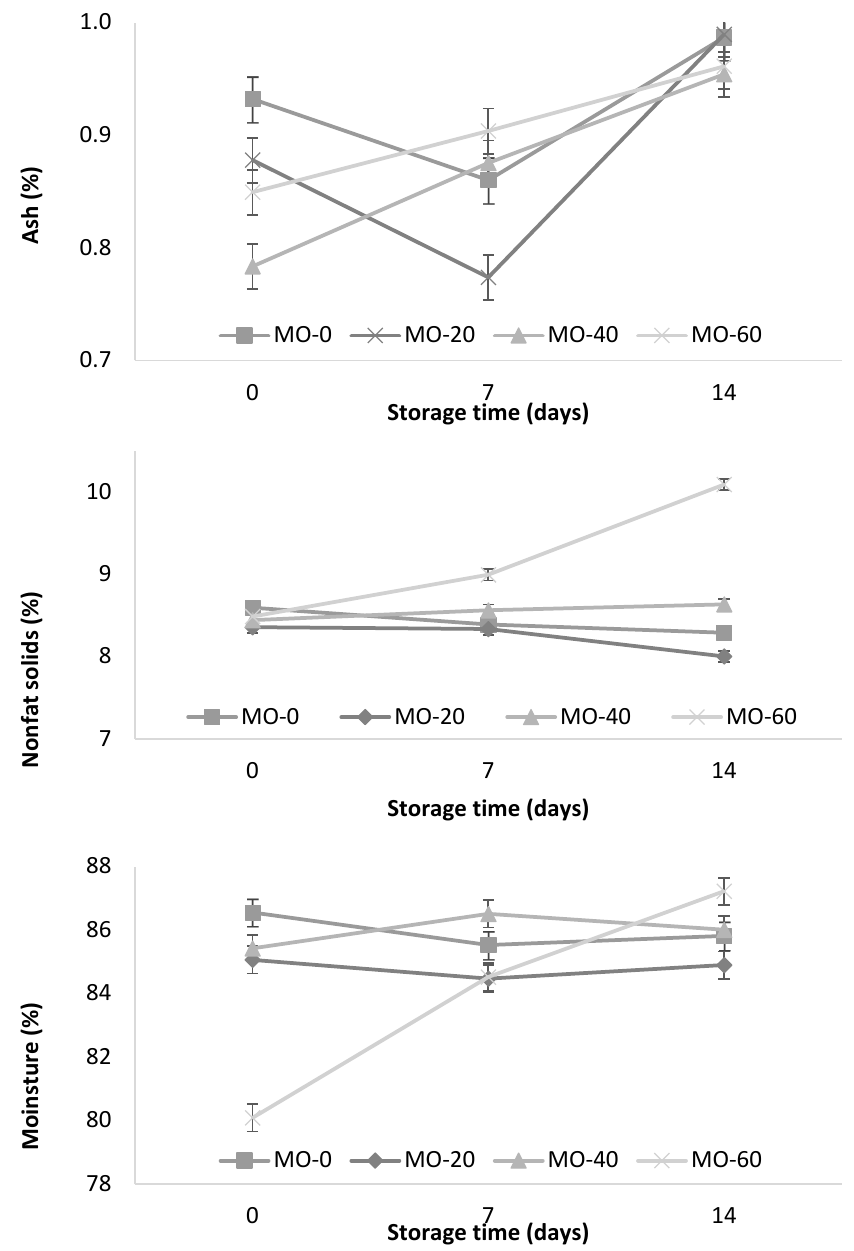
Figure 3. Storage changes in ash, nonfat solids, and moisture content of yogurt from sheep fed with Moringa oleifera extracts. Bars denote standard error of the means.